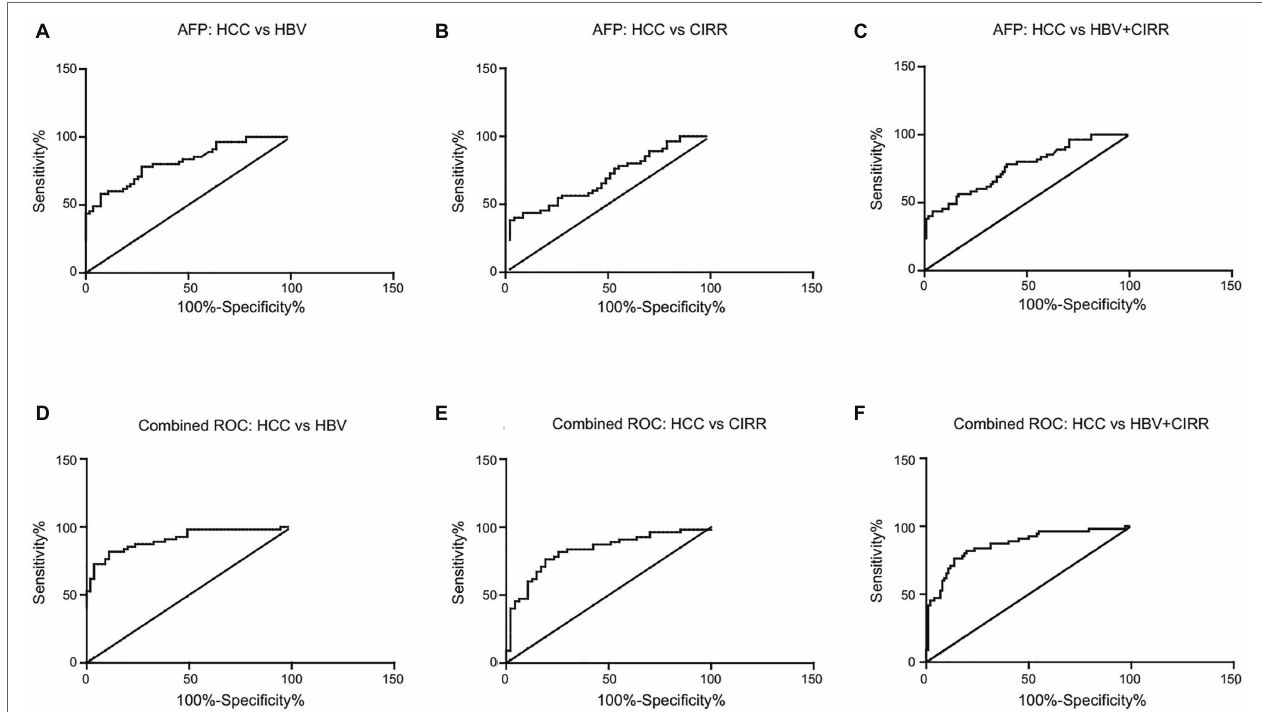
FIGURE 5 | The combination of AFP and hsa_circ_0028861 for HCC diagnosis. (A–C) ROC curves of AFP for discriminating HCC from chronic HBV (A) , cirrhosis (B) or the combination of chronic HBV and cirrhosis patients (C) , respectively. (D–F) ROC curves of the combination of hsa_circ_0028861 and AFP for discriminating HCC from chronic HBV (D) , cirrhosis (E) , or the combination of chronic HBV and cirrhosis patients (F) , respectively. HBV, hepatitis B virus; CIRR, cirrhosis; and HCC, hepatocellular cancer.